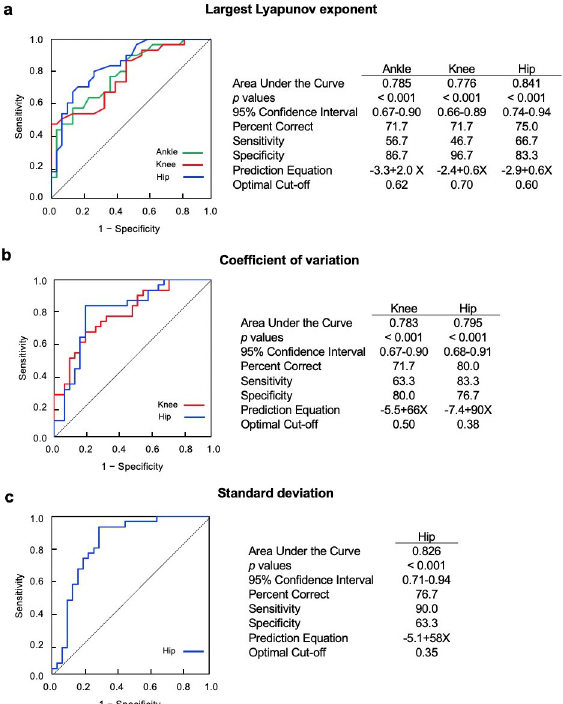
Fig 5. Results from Receiver Operating Characteristics (ROC) curve and logistic regression analyses. Six dependent variables have significant relationship exist with disease status and all of them have area under the curve � 0.75. a) ROC curves for Largest Lyapunov exponent of ankle, knee, and hip ranges of motion, b) ROC curves for coefficient of variation of knee and hip ranges of motion, c) ROC curve for standard deviation of hip range of